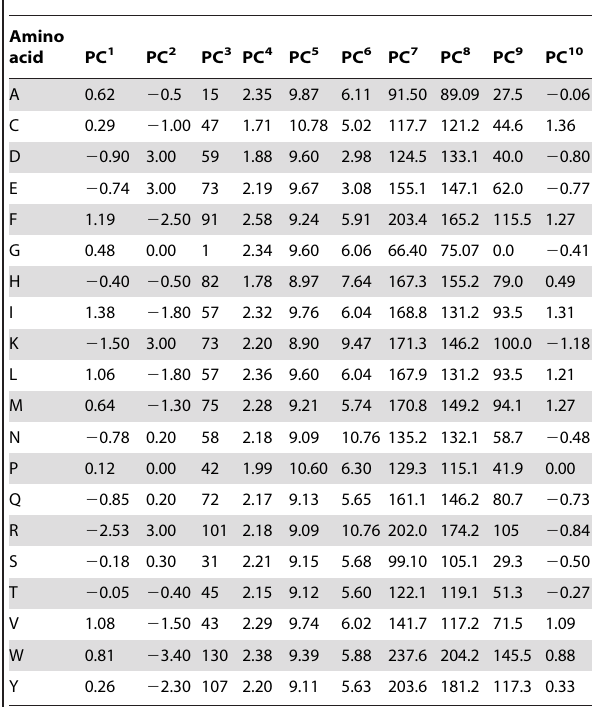
Table 2. List of the values of the ten physical-chemical properties for each of the 20 native amino acids.